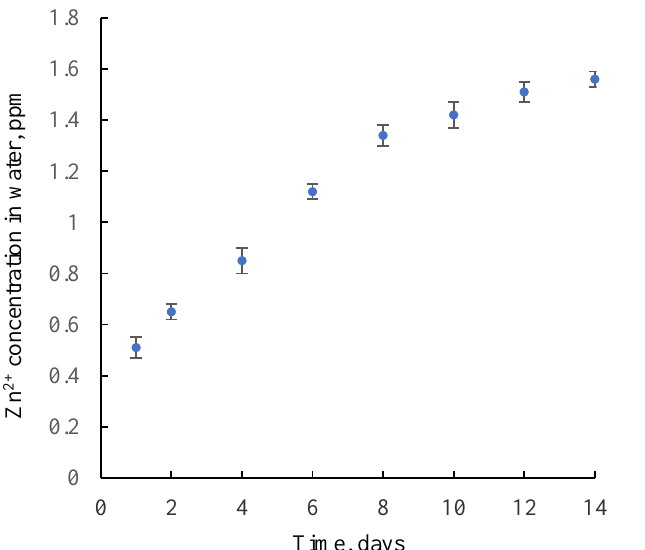
Figure 10. The assay of zinc ions released from BC-ZnO NPs-BDP nanocomposite films as membrane in water as a function of time using Franz vertical diffusion cells.